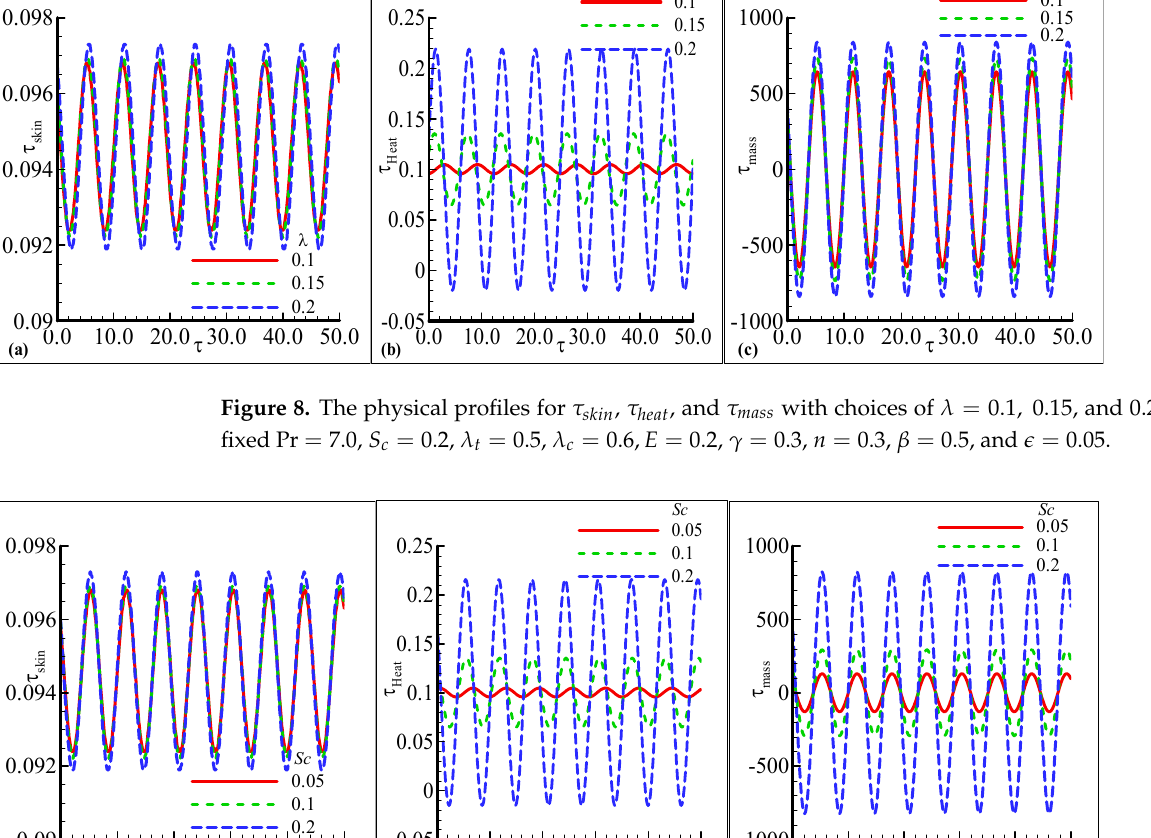
Figure 7. The physical profiles for 𝜏 (cid:3046)(cid:3038)(cid:3036)(cid:3041) , 𝜏 (cid:3035)(cid:3032)(cid:3028)(cid:3047), and 𝜏 (cid:3040)(cid:3028)(cid:3046)(cid:3046) with choices of 𝛾 (cid:3404) 0.01, 0.05, and 0.09 and fixed Pr (cid:3404) 7.0 , 𝑆 (cid:3030) (cid:3404) 0.2 , 𝜆 (cid:3047) (cid:3404) 0.2 , 𝜆 (cid:3030) (cid:3404) 0.6𝐸 (cid:3404) 0.2 , 𝑛 (cid:3404) 0.3 , 𝜆 (cid:3404) 0.2 , 𝛽 (cid:3404) 0.2, and 𝜖 (cid:3404) 0.05 .